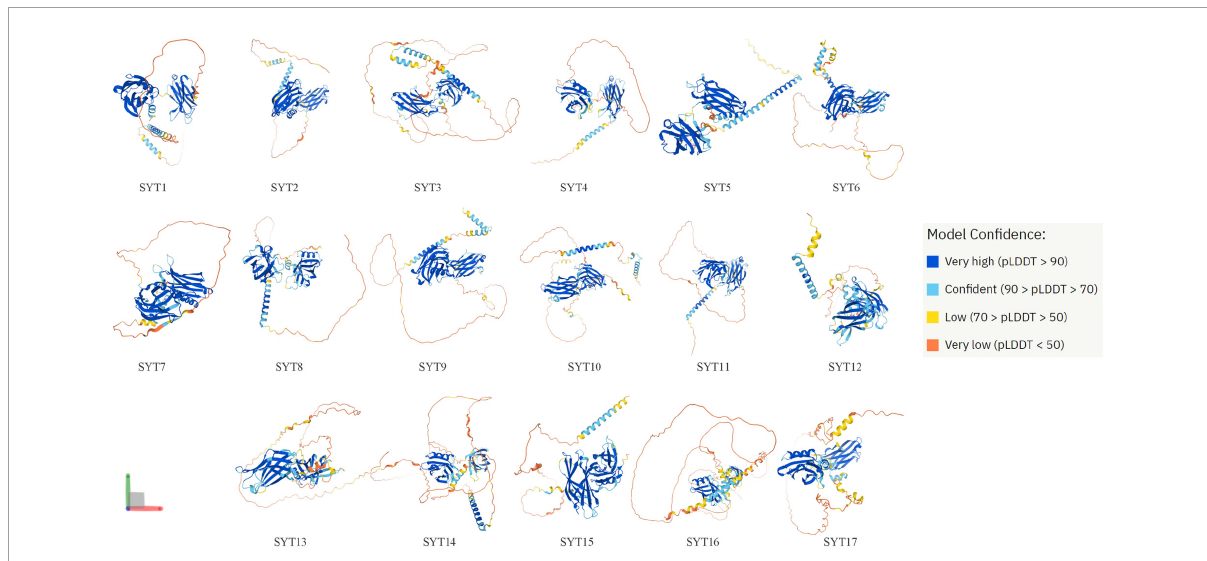
FIGURE1 Structure of 17 human synaptotagmin family members predicted by AlphaFold. AlphaFold is an AI system developed by DeepMind that predicts a protein’s 3D structure from its amino acid sequence. AlphaFold produces a per-residue confidence score (pLDDT) between 0 and 100. Some regions below 50 pLDDT may be unstructured in